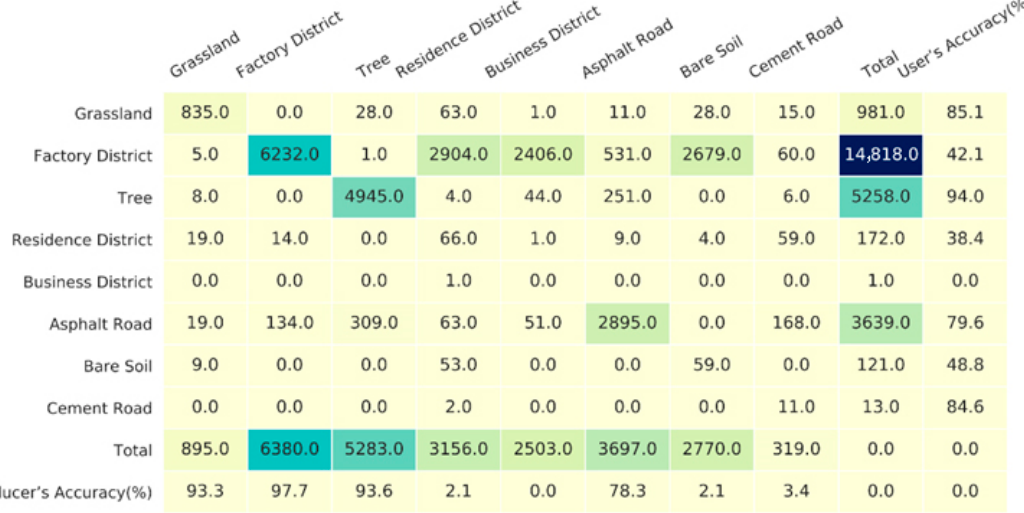
Figure 6. Confusion matrix of the classification results derived when single-angle images were employed as the input data (average values obtained with single-angle images corresponding to 10 angles).